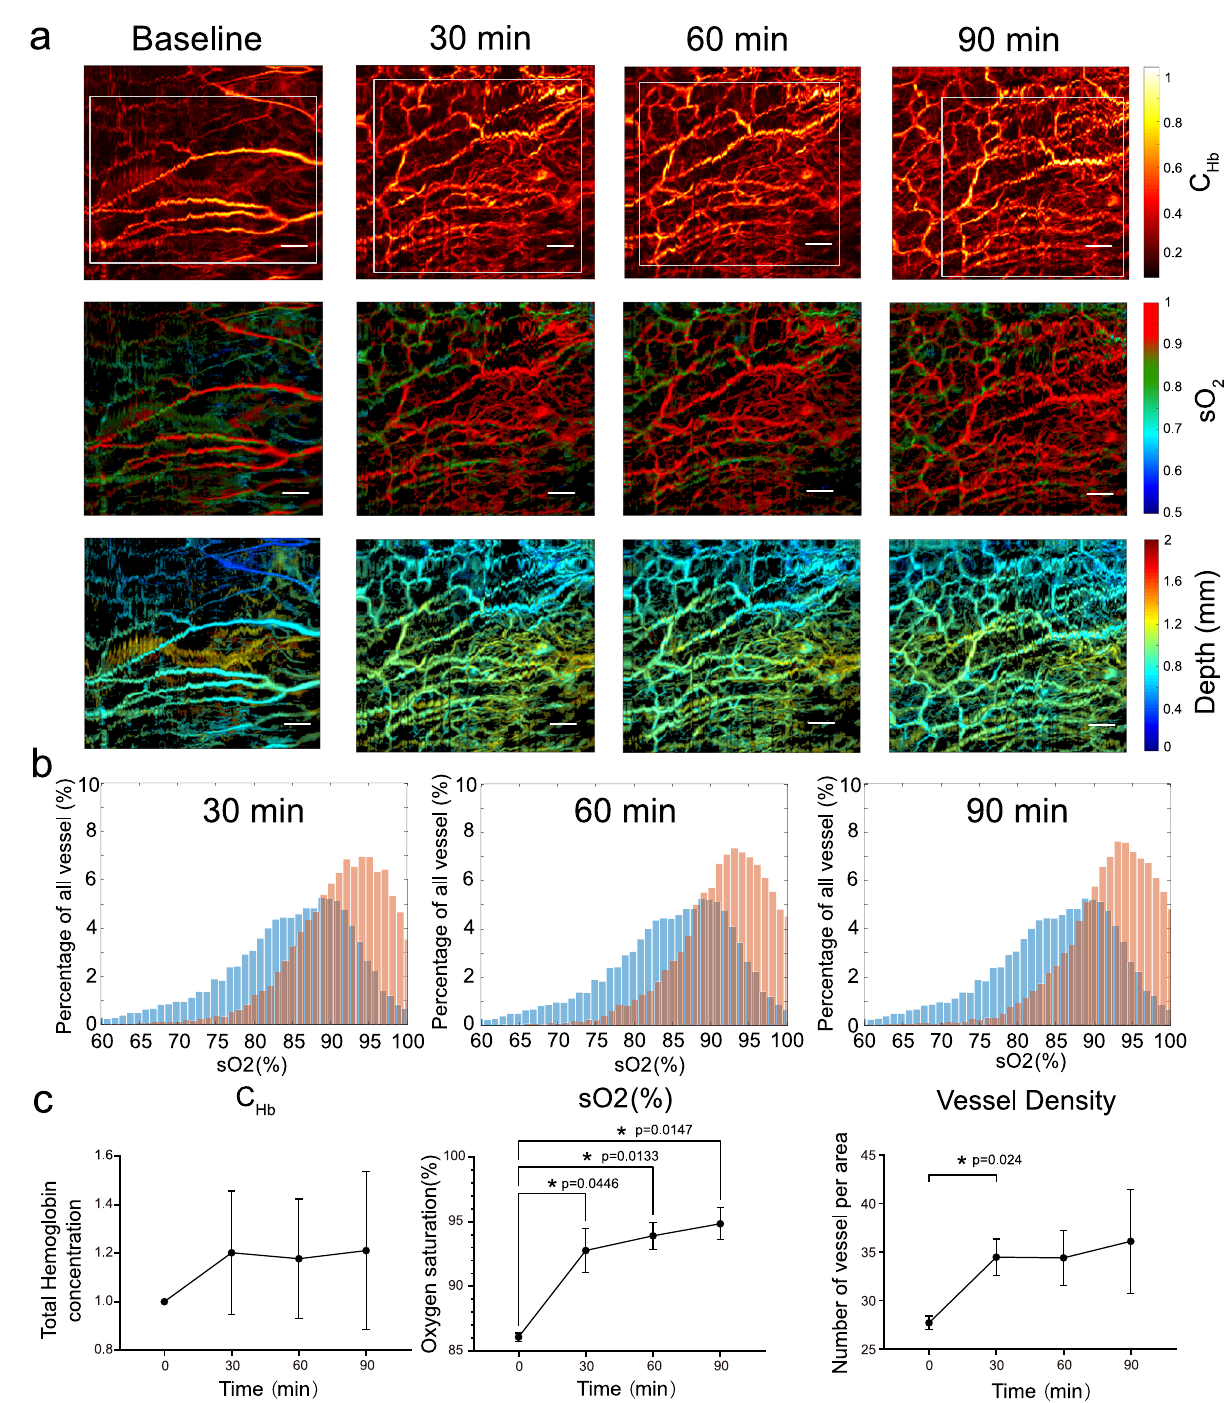
Fig. 4 | Endoscopic imaging of a rat rectum for visualization of the hemody- namicresponseduringacutein fl ammation.a Time-lapseimagesacquiredbythe photoacoustic endoscope over 90min. The hemoglobin concentration (C Hb ), depth, and oxygen saturation (sO 2 ) images are presented. The white boxes represent the same imaging region of interest for the statistics. b Oxygen satura- tion distribution changes with respect to the baseline at 30min intervals. Blue: